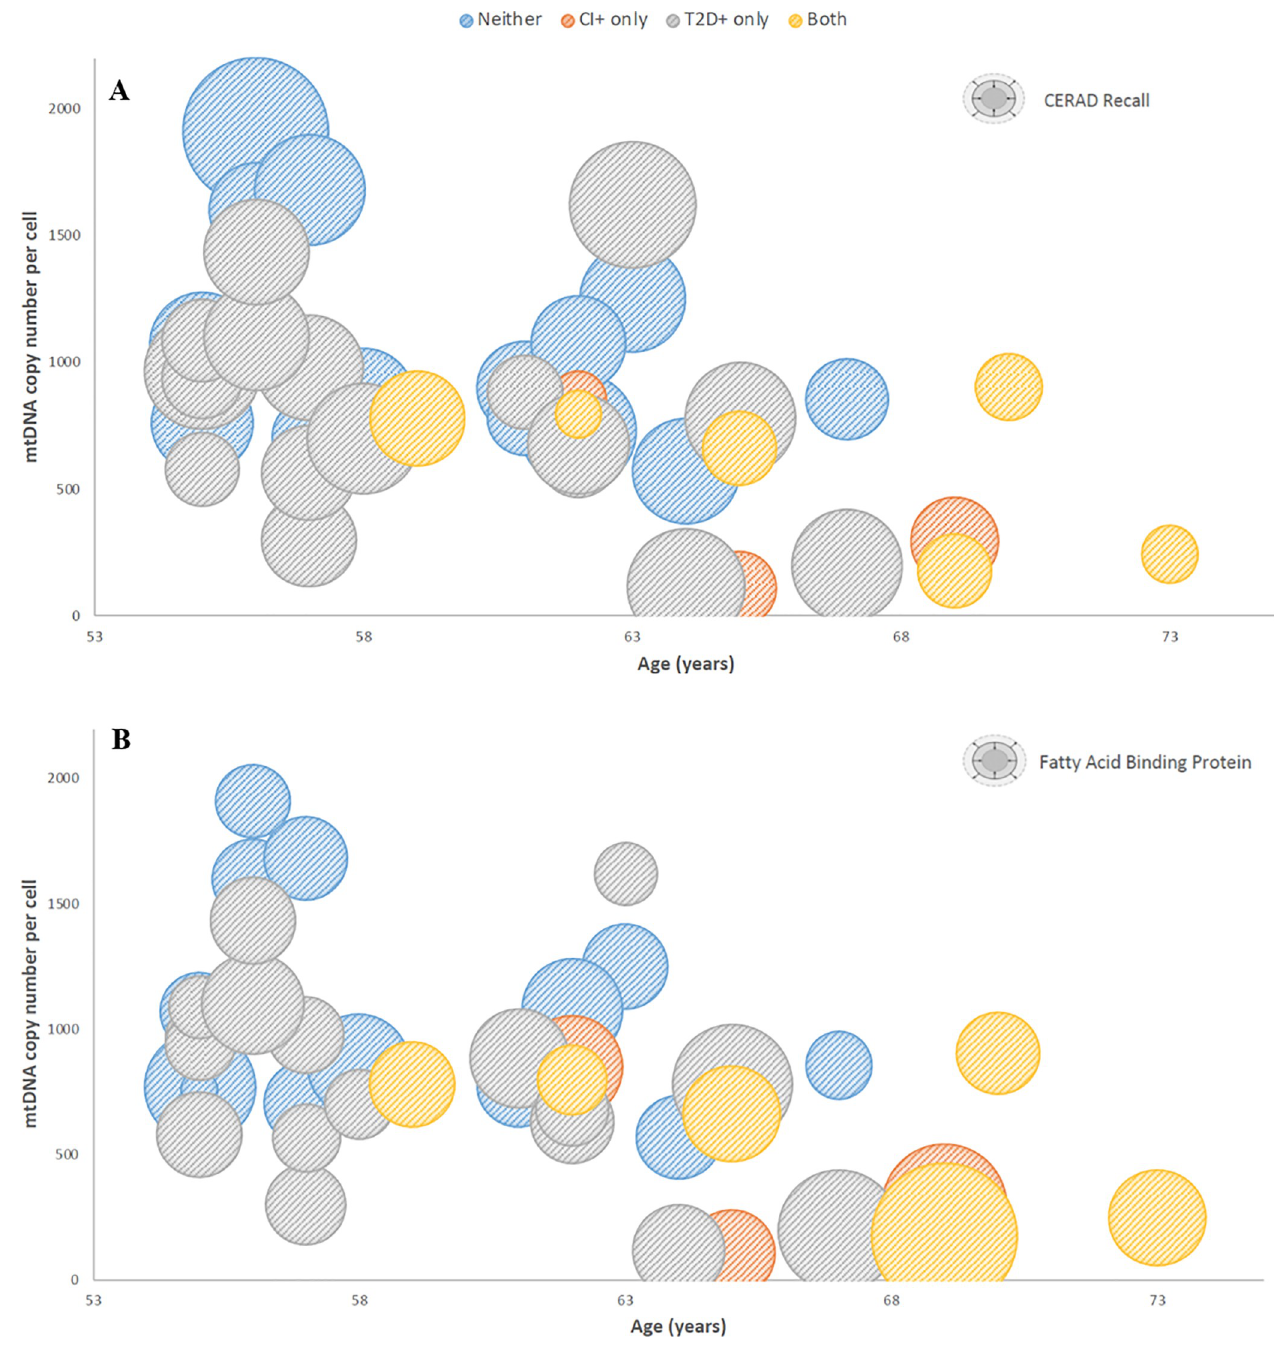
Fig 7. Correlations between age, mitochondrial DNA copy number, CERAD and FABP levels. Bubble charts displaying significant correlations between age, mitochondrial DNA copy number and (A) CERAD recall score [observed range 2–19, higher indicating better cognitive function] (Pearson’s corr. = 0.464, p-value = 0.001); (B) fatty acid binding protein levels (Pearson’s corr. = -0.363, p-value = 0.007) (indicated as size of bubble). Age and mtDNACN have a significant negative correlation (Pearson’s corr. = -0.288, p-value =